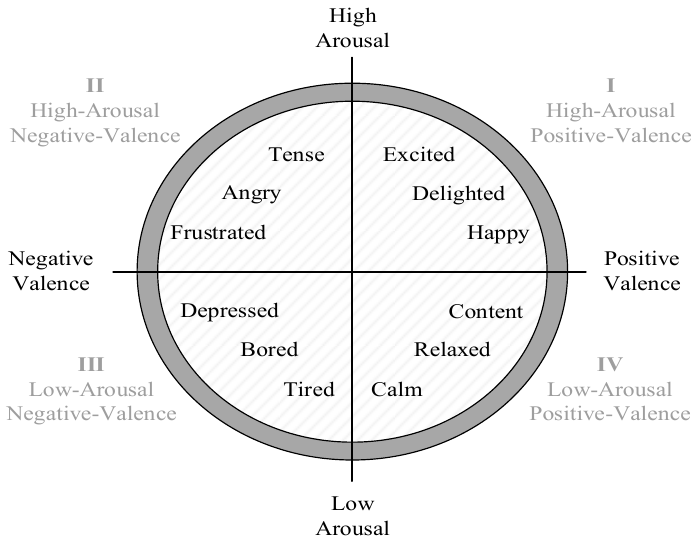
Figure 2. General structure of arousal-valence dimension.